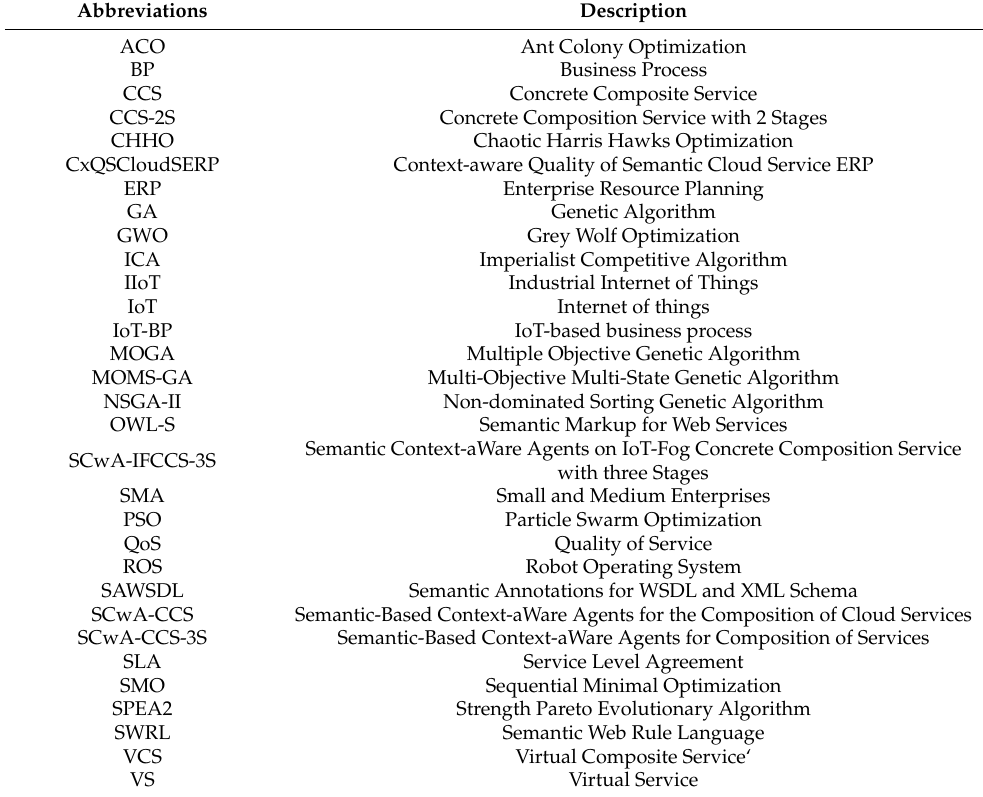
Table 2. Abbreviations used in this